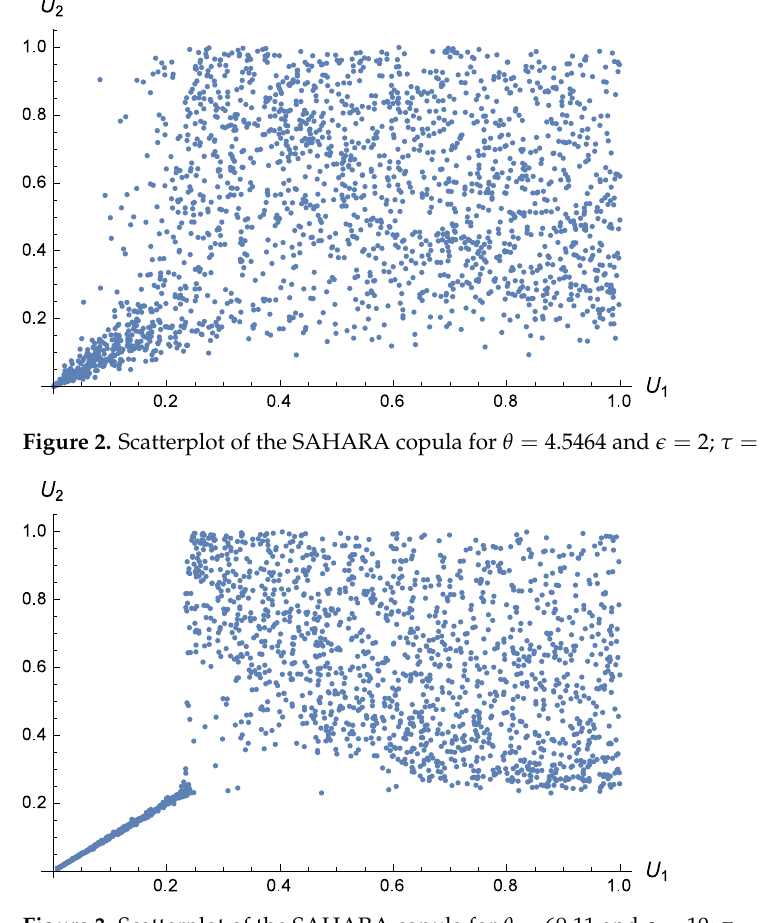
Figure 3. Scatterplot of the SAHARA copula for θ = 69.11 and (cid:101) = 10; τ =